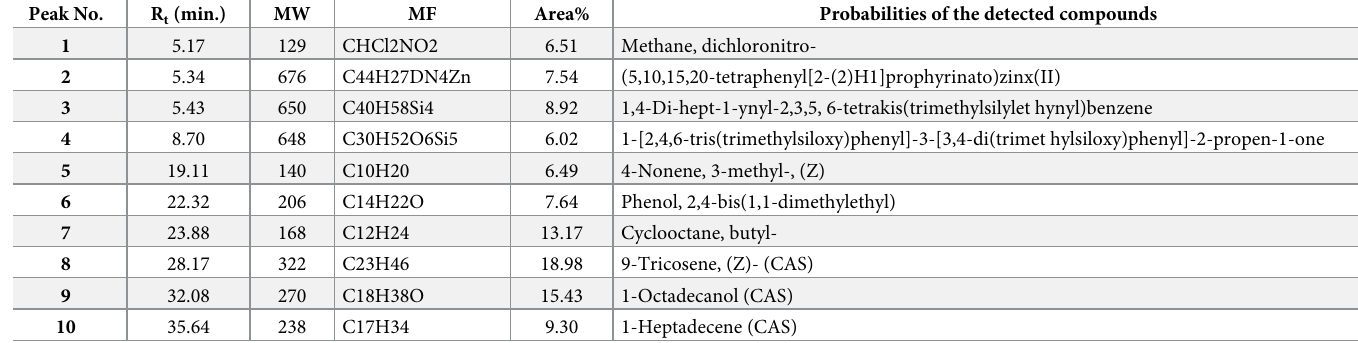
Table 2. Chemical characterization of rice bran oil via GC-MS analysis. Peak